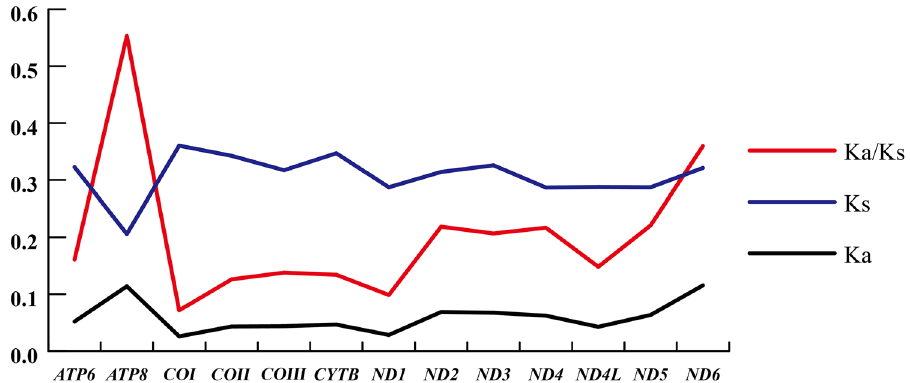
Figure 3. The Ka/Ks analysis of 13 protein-coding genes of the mitochondrial genomes of Syrphidae. The image was computed by DnaSP v4 (http:// www. ub. es/